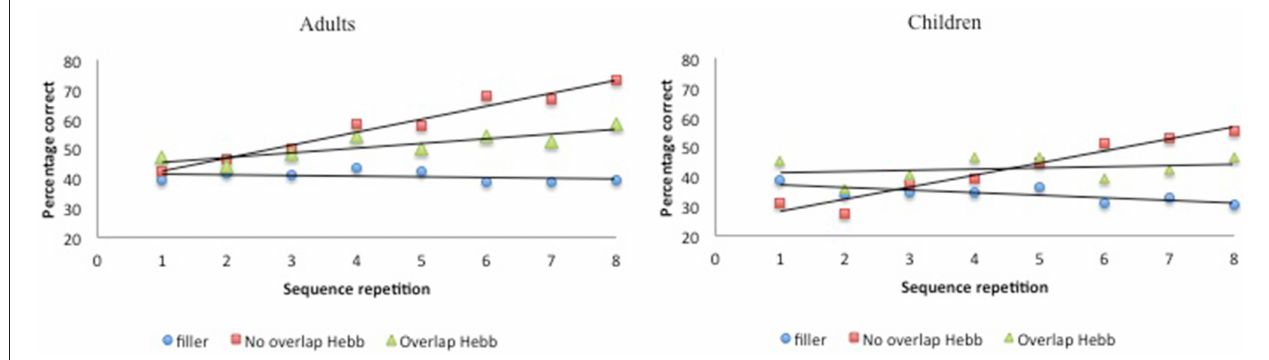
FIGURE 2 | Performance (percentage of correct scores) as a function of Sequence type (filler vs. Hebb non-overlap vs. Hebb overlap) and Sequence repetition (1–8) in both children and adults, Experiment 1. Left panel : performance for adults. Right panel : performance for children.